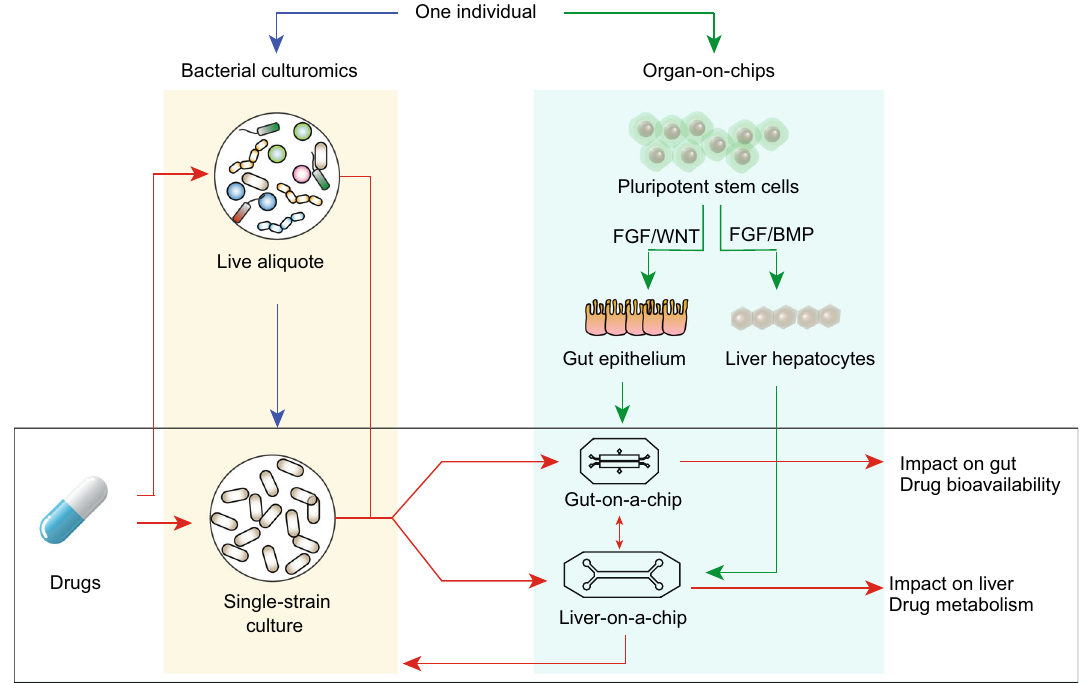
Figure 6. Individual-based drug testing. Advance of bacterial “ culturomics ” , development of organs-on-chip and high-throughput metabolism and pharmacokinetic analyses, will enable individual-based in vitro drug testing in the near future. For this purpose, liver gut microbiome can be collected for culturing. This can be done either on whole community level or on individual species or strain level (blue arrows). Currently, organs-on-chips are emerging as a next-generation drug-testing model system. Non-invasive collection of urine leads to human induced pluripotent stem cells from which we can generate different types of tissue cells (e.g., gut epithelial cells or hepatocytes) (green arrows). These cells will have exactly the same genetic background. Coupling cultured bacteria and organs-on-chip offers a high potential to conduct individual-based drug testing, by taking into consideration both an individual ’ s own genome and his/her metagenome